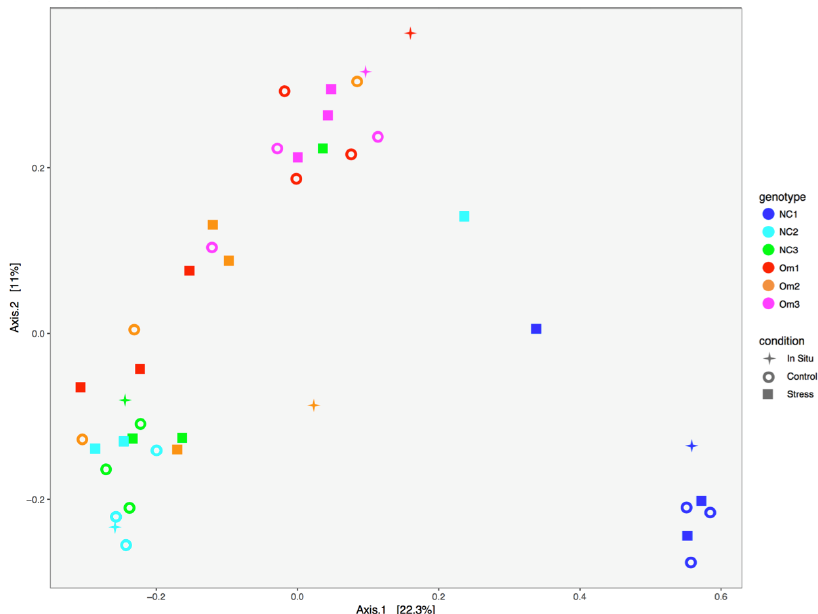
Figure 2 . Principal coordinate analysis plot for Bray-Curtis distances of the bacterial composition of each colony in each experimental condition. Different colors represent different colonies, the stars represent the in situ conditions, the open circles represent the control conditions, and the squares represent the stress